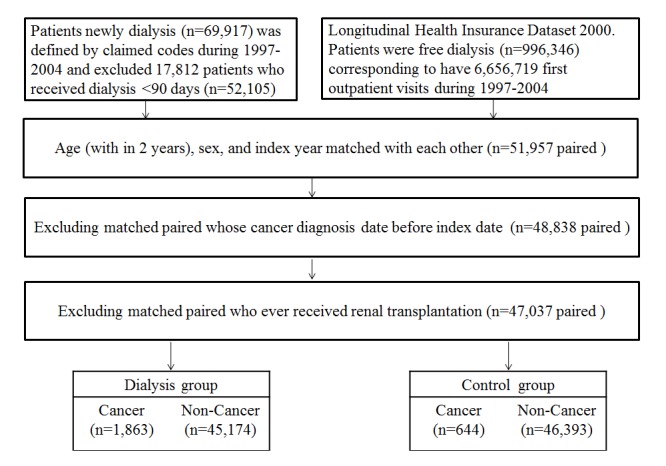
Flow diagram illustrating the selection of patients and controls.